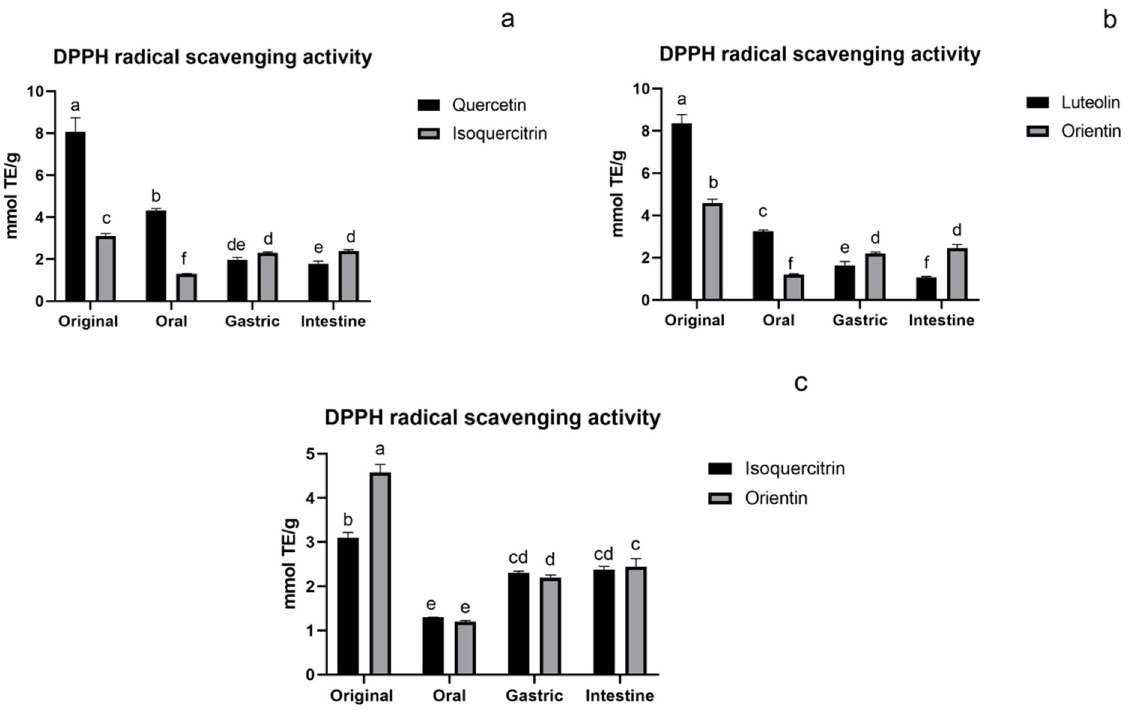
Figure 2. DPPH assay of flavonoids: ( a ) flavonoid O-glycoside and its aglycone, ( b ) flavonoid C-glycoside and its aglycone, and ( c ) flavonoid O-glycoside and flavonoid C-glycoside. The results are reported as means ± SD. Different letters in the figure indicate significant differences ( p < 0.05).